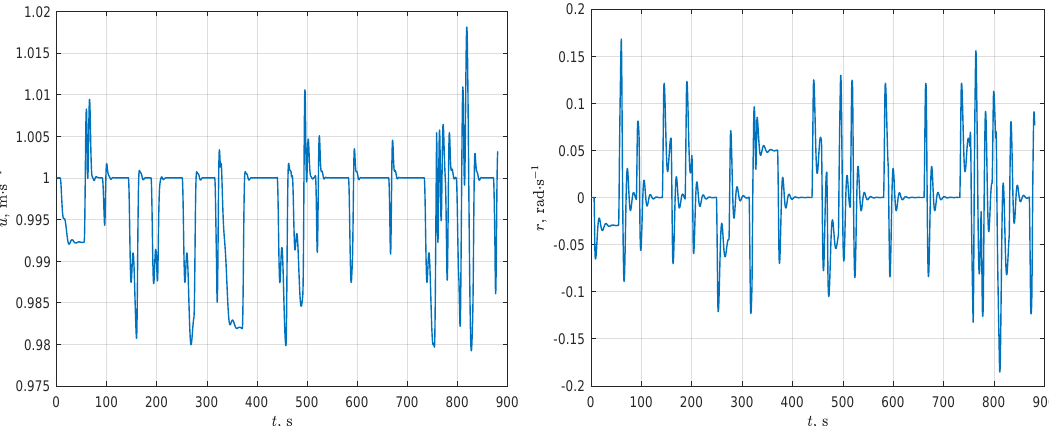
Figure 10. Path-following errors for Scenario 1: along path error s e (left-hand part) and across path error y e (right-hand part).